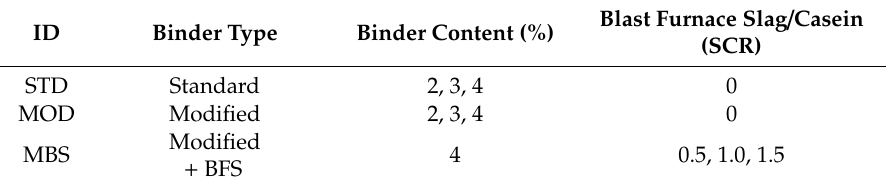
Table 5. Types of binder and binder